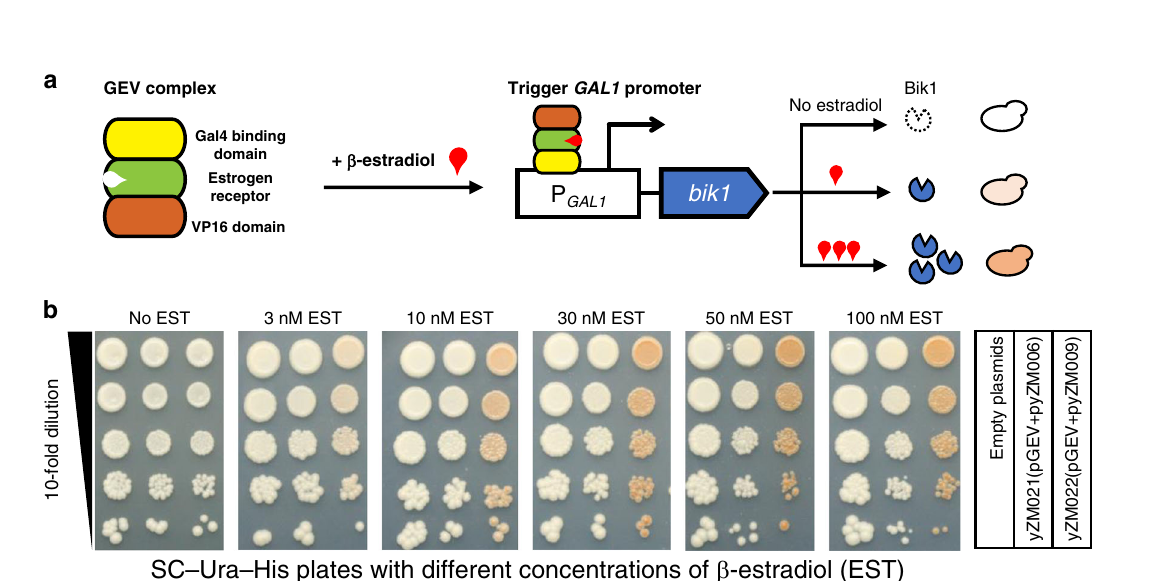
Fig. 2 Identifying bottlenecks in the bikaverin pathway. a GFP-mapping strategy to identify bottlenecks. Each bikaverin pathway gene (in gray) was tagged with GFPtag (in green) separately to check their expression and Bik1 was identi fi ed as the bottleneck in the pathway. b The results of fl uorescence checking in GFP-mapping strategy. Scale bar = 20 µ m. c Fluorescence of Bik1-GFP using different promoters. Scale bar = 50 µ m. d Western blots to check expression of C-terminally His-tagged Bik1 using different promoters. GAPDH was used as the internal reference protein. The original uncropped source image is provided in Supplementary Fig. 12. e Quantitative relative expression level of Bik1 using these promoters. Relative expression level was the intensity of Bik1 band divided by the intensity of internal reference GAPDH band. Data are presented here as mean values± standard deviation (SD) calculated from n = 3 biological replicates. f The production of bikaverin in strain yZM009 was con fi rmed by HPLC analysis. Experiments in b – d were repeated three times independently with similar results. Source data underlying Fig. 2e are provided as a Source Data fi le.